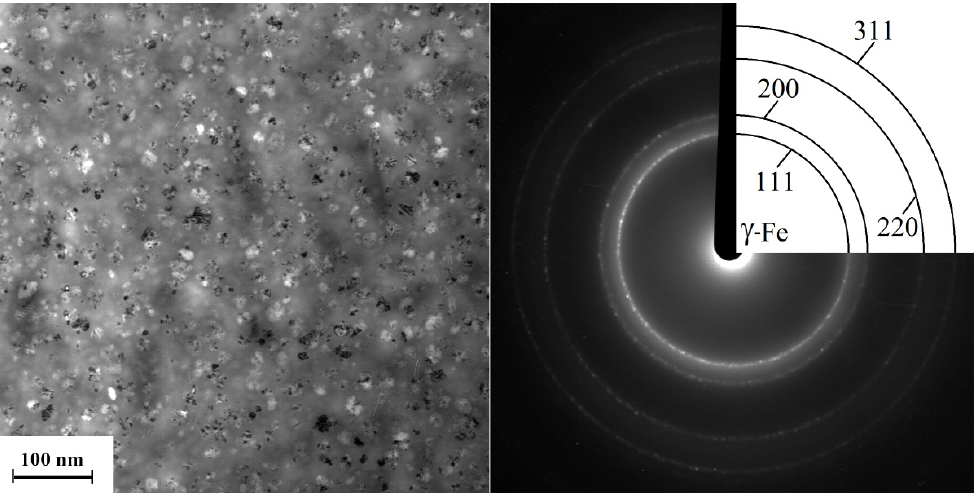
Figure 7. Bright-field image (TEM) of the Fe 50 Ni 33 B 17 AA structure after annealing at T an = 743 K, 1 h.